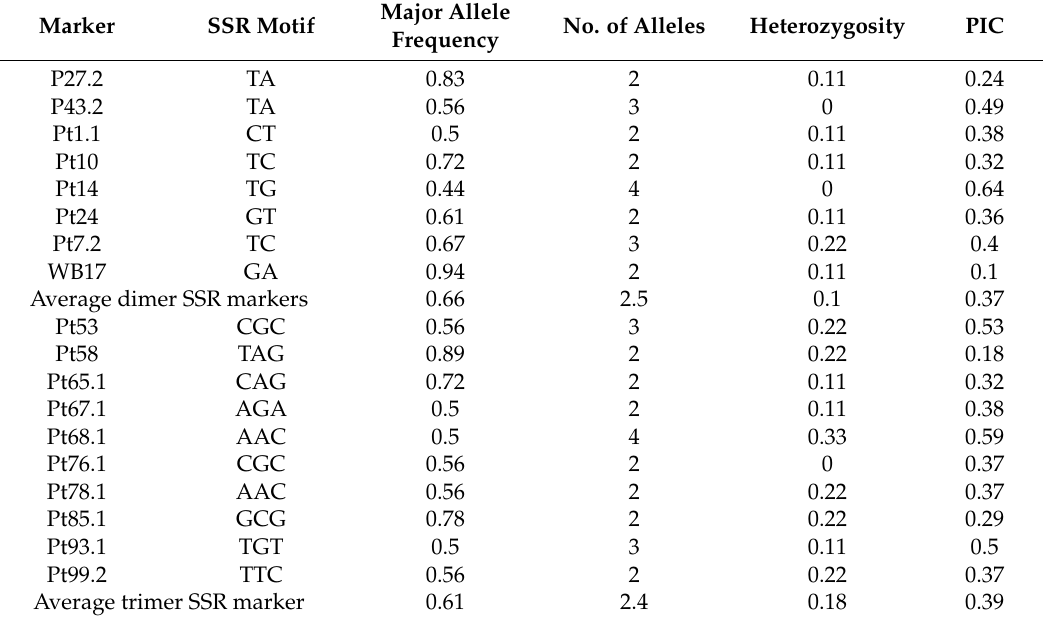
Table 6. A summary of data analysis of 18 SSR markers. PIC, polymorphic information